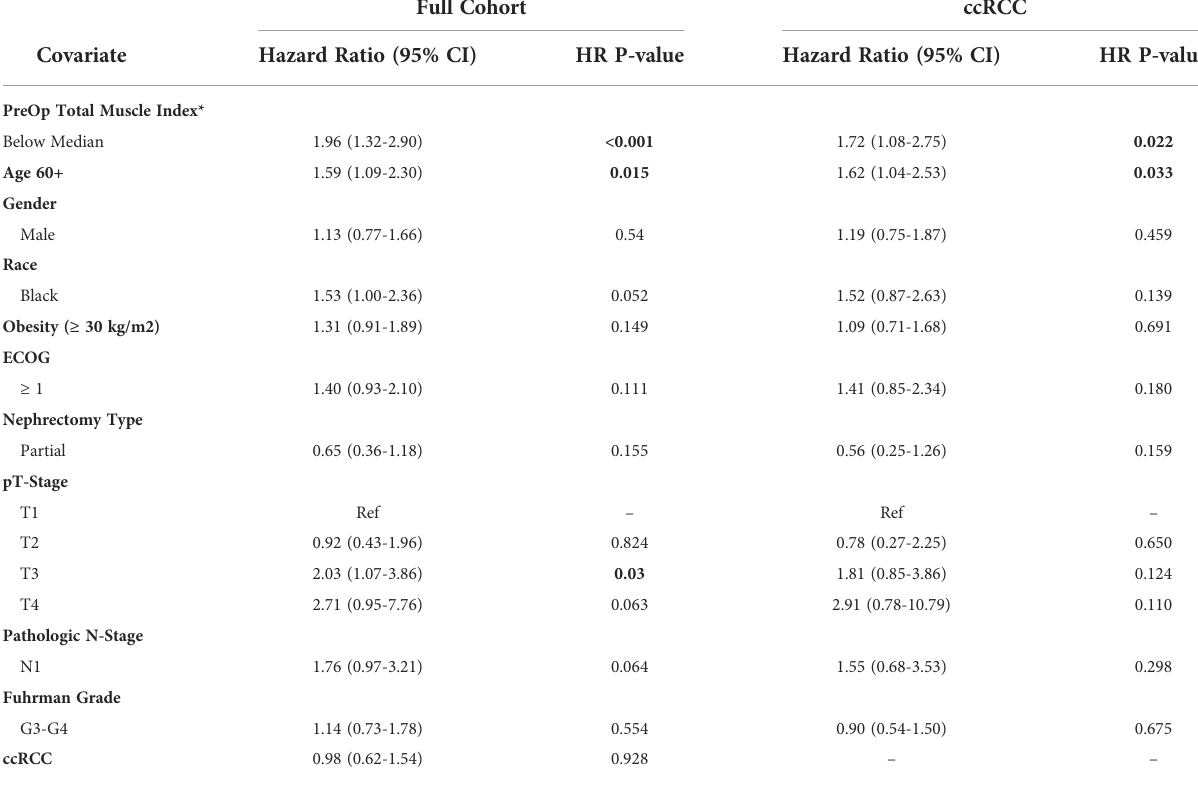
TABLE 2 Multivariable model summary of COX hazard overall survival for binary preoperative linear muscle